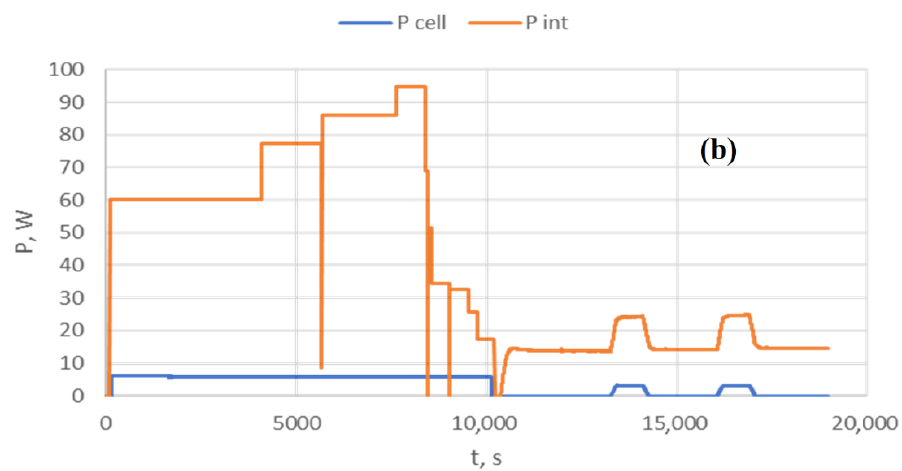
Figure 3. Cell and internal shell temperatures ( a ) and heater power ( b ) during real measurement. Both modes of operation were used — heating to about 500 °C ( t < 10,000 s ), and adiabatic mode for specific heat measurement ( t > 10,000 s ).